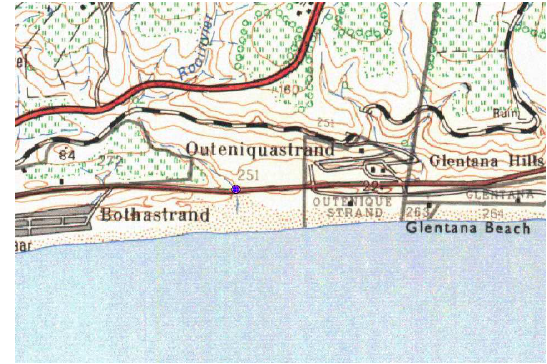
Figure 2: Example of topographical data in raster format. Source: Dept. of Land Affairs.